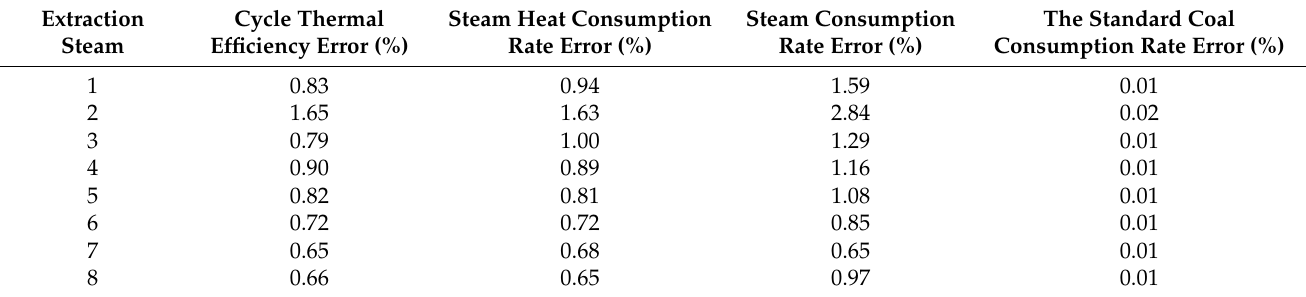
Table 6. Economic errors of replacing all levels under partial variable